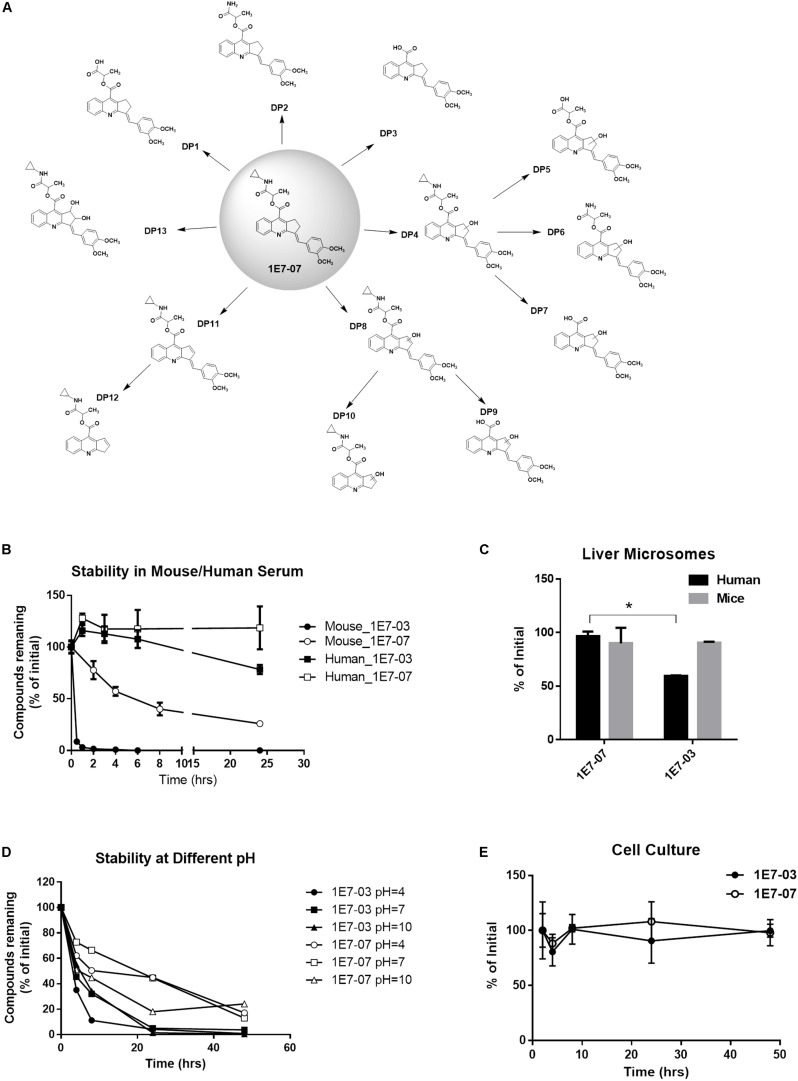
Cytotoxicity and stability of 1E7-07. (A) Degradation pattern of 1E7-07. 1E7-07 was incubated under different experimental conditions, including mouse plasma (24 h) and buffers with pH 4, pH 7, and pH 10 (48 h) at 37°C. Degradation products (DPs) were extracted with cold acetone precipitation and identified by LC/FT-MS analysis. A total of 13 DPs were identified. (B) Stability of 1E7-07 in human and mouse serum. 1E7-07 or 1E7-03 (10 μM) was added to human or mouse serum and incubated at 37°C for 24 h. Samples were collected at different time points, and compounds were extracted and quantified by LC/FT-MS analysis. (C) Stability of 1E7-07 in liver microsomes from human and mouse. 1E7-07 or 1E7-03 dissolved in DMSO (10 mM stock solution) was mixed with liver microsomes to the final concentration of 10 μM and incubated at 37°C for 1 h. Samples were processed and analyzed by LC/FT-MS. Shown are the means ± SD of triplicates. ∗p < 0.001, 1E7-07 versus 1E7-03 in human liver microsomes. (D) Degradation kinetic of 1E7-07 under different pH. 1E7-07 or 1E7-03 (10 μM) was incubated at 37°C in sodium acetate-acetic acid buffer (pH = 4), NaH2PO4/Na2HPO4 buffer (pH = 7) and NaHCO3/NaOH buffer (pH = 10). Samples collected at different time points up to 48 h and processed for LC-MS analysis. (E) Stability of 1E7-07 during the cell culture. 1E7-07 or 1E7-03 (10 μM) was added to the media and incubated at 37°C for 48 h. Samples were collected at different time points. Remaining compounds were extracted and quantified by LC/FT-MS analysis.